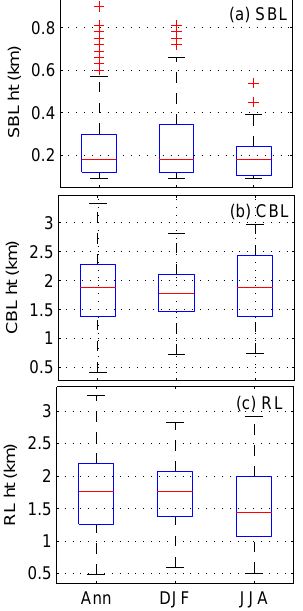
Figure 8. Box plot (representing median and interquartile ranges) of (a) SBL height, (b) CBL height, and (c) RL height for annual (Ann) winter (DJF) and summer monsoon (JJA) from the data observed during December 2010–March 2014.